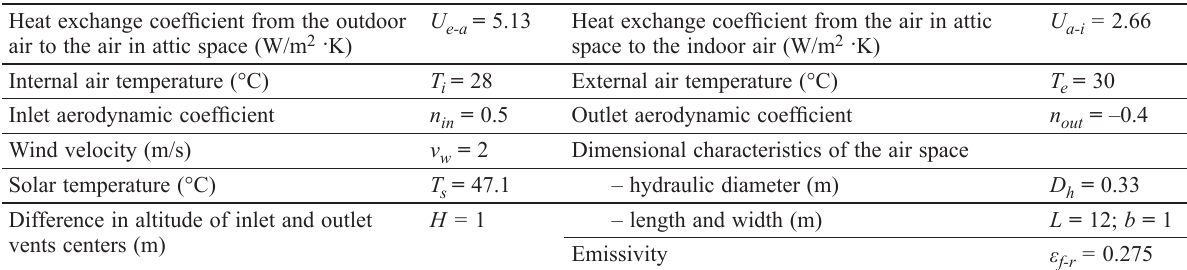
Table 3. Initial data for the comparative calculations of the attic space (according to Bogoslovsky)